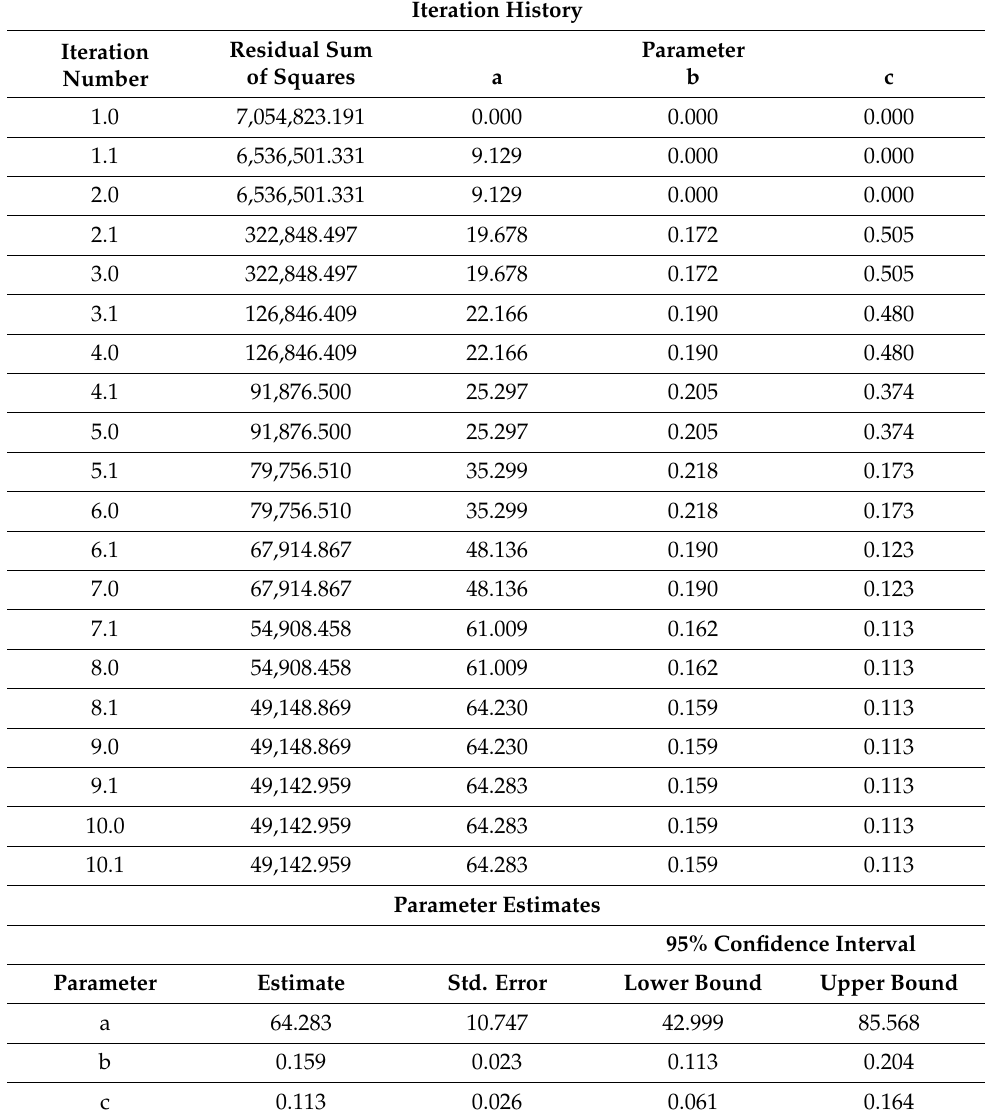
Table 3. SPSS outcome for nonlinear regression analysis to predict the microhardness of